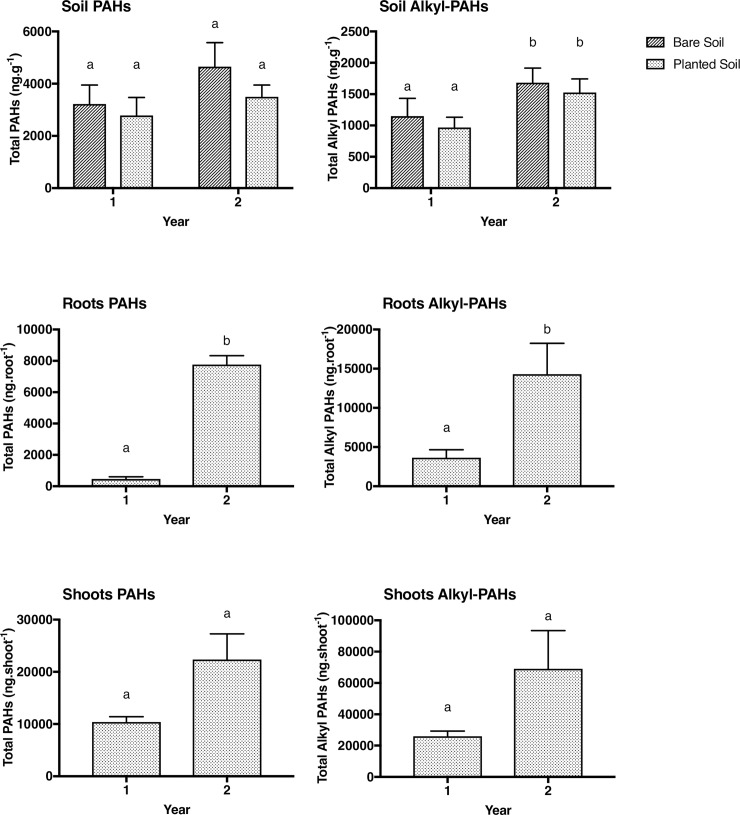
Mean (±SE) PAHs and alkyl-PAH concentrations soil (dry weight) and Total PAHs and Alkyl PAHs in roots (ng.root-1) and shoots (ng.shoot-1) (n = 10) of E. purpurea at the field site.Data were analyzed using a one-way ANOVA for roots and shoots. Different letters indicate significant differences according to Tukey’s post-hoc test.